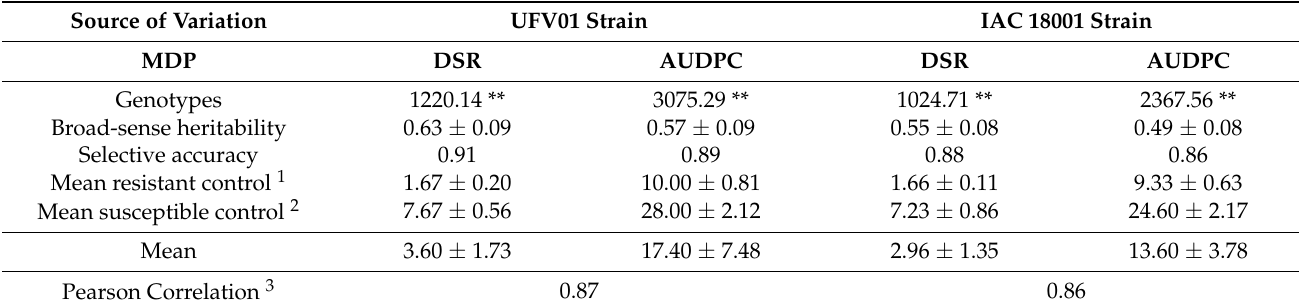
Table 1. Broad-sense heritability, selective accuracy for resistance, overall mean of controls for two Fop strains evaluated for the Mesoamerican Diversity Panel (MDP) and likelihood radio test (LRT) of random effects of the DSR and